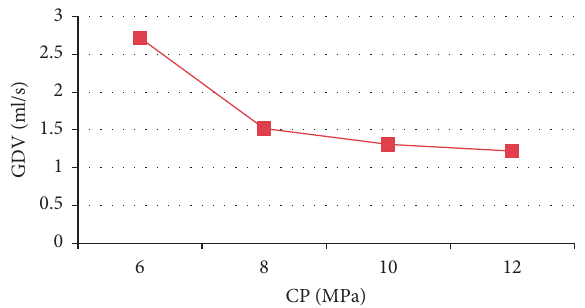
Figure 4: Change in gas desorption velocity with confining